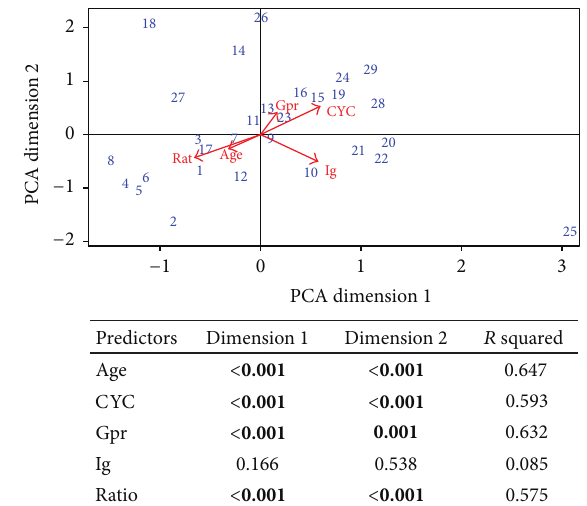
Figure 2: Principal component analysis of the five predictors during RTX maintenance. Data is standardized. 𝑃 values and 𝑅 squared of each predictor are presented in the included table. 1–29: patients’ study number; age; CYC: cyclophosphamide cumulative dose; Gpr: gram of RTX per round; Ig: total level of immunoglobulin prior rituximab; Rat: ratio CD4/CD8 prior rituximab.